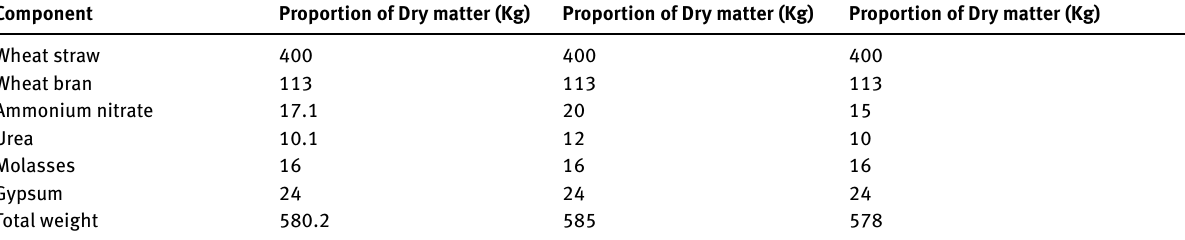
Table 3: Modified Wheat straw composts in Turkey (Colak et al. 2007; Baysal et al. 2007) Component